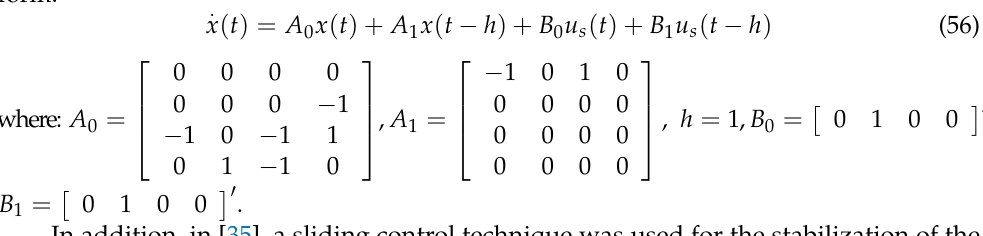
≤ u . Figure 9. Evolution of the states with | u | ≤ ≤ u .